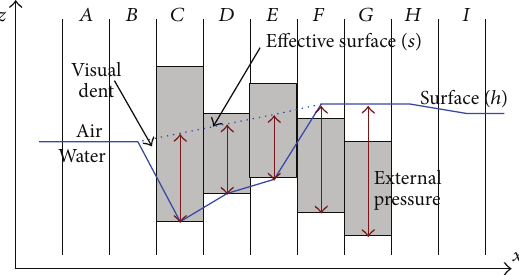
Figure 3: A side view explaining surface, effective surface, and pressure. Surface, the top of the topmost water column, is pushed down by the body. Effective surface is an estimate of where the surface would be without the body and is calculated by adding the external pressure to the surface (see Section 3.6). These two surfaces only differ in cells where the surface is pushed down by a